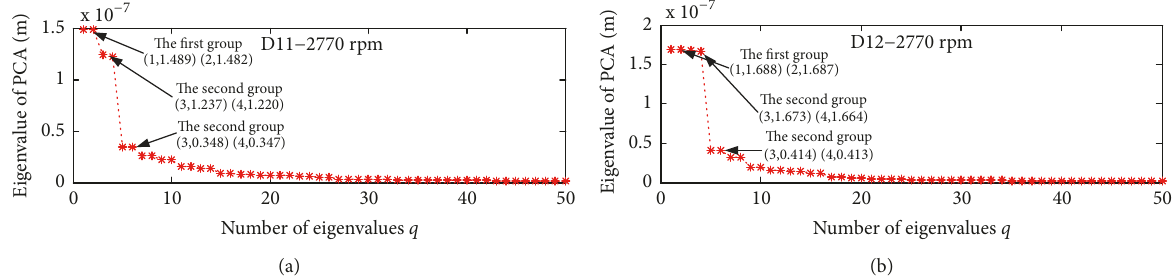
Figure 15: The eigenvalues distribution of covariance matrix C . (a) The eigenvalues distribution of D11. (b) The eigenvalues distribution of